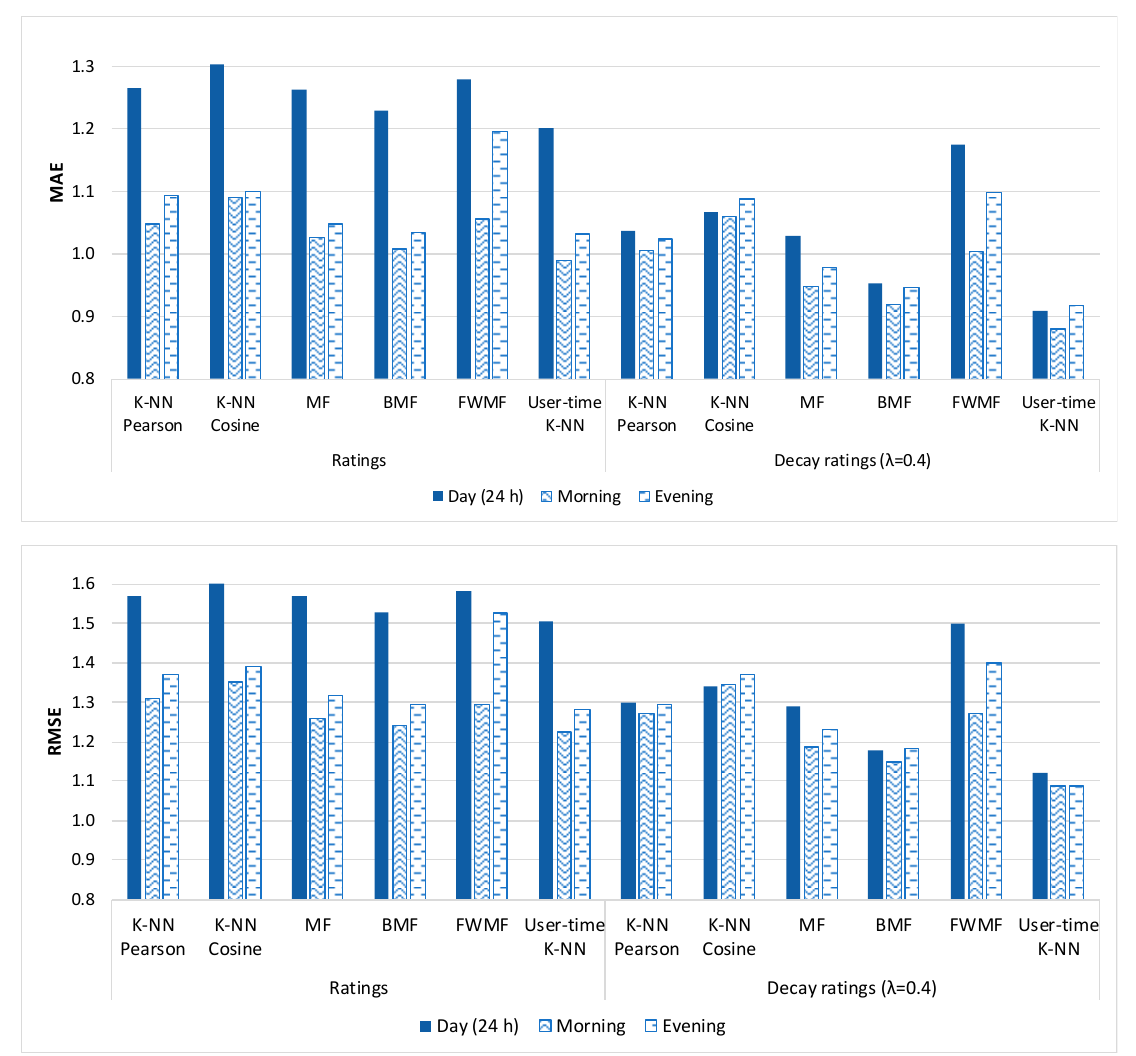
Figure 8. Comparison of the MAE and RMSE values obtained for the three periods studied using different methods.